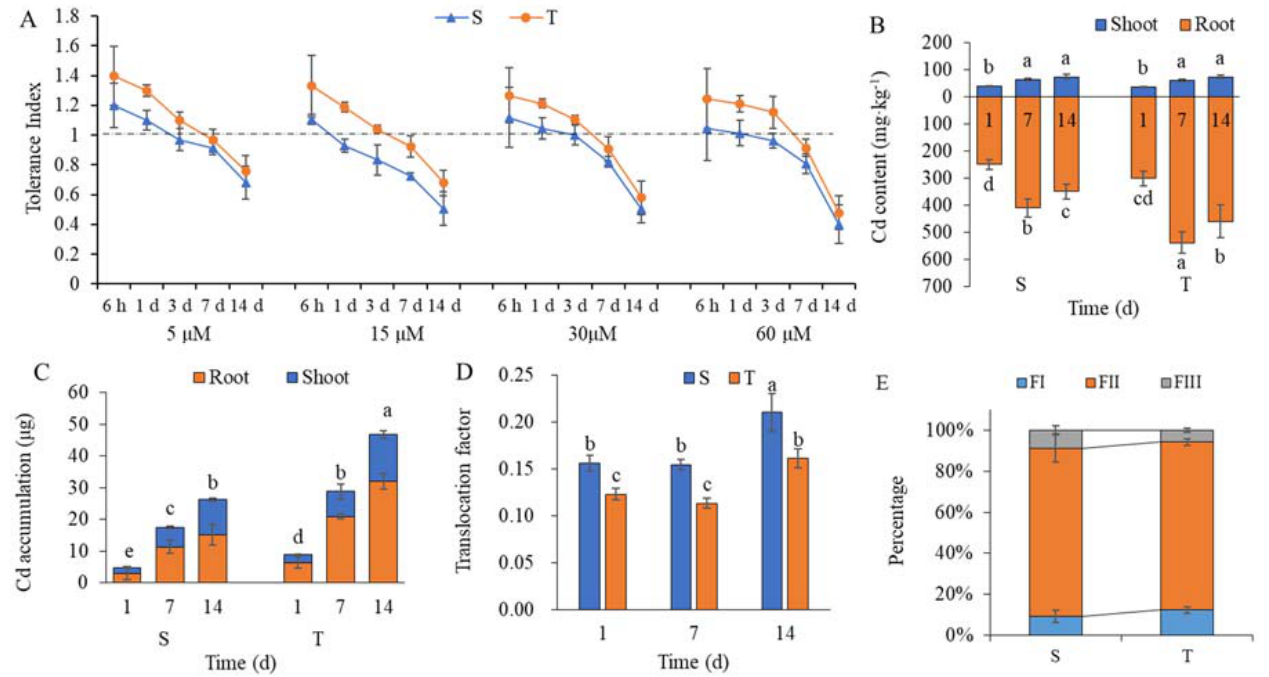
Figure 1. Effect of Cd stress on Cd tolerance index ( A ), concentration ( B ), accumulation ( C ), translocation factor ( D ), and subcellular distribution ( E ) of broomcorn millet varieties S (Cd-sensitive) and T (Cd-tolerant). The results shown in the graphs are means ± SE ( n = 3). The timepoints at 6 h, 1 day, 3 days, 7 days, and 14 days represent the range of Cd stress time durations, while 5 µ M, 15 µ M, 30 µ M, and 60 µ mol/L represent the range of Cd stress concentrations. Different lowercase letters indicate significant differences at a p < 0.05 threshold among different Cd treatments and varieties.